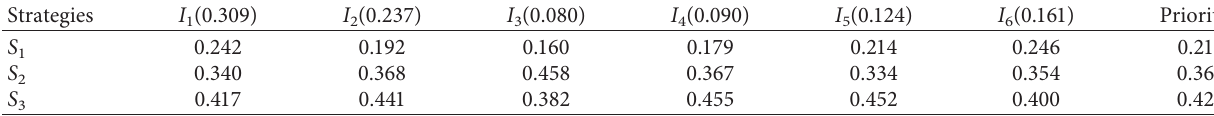
Table 18: Calculations of overall priorities between alternative options.